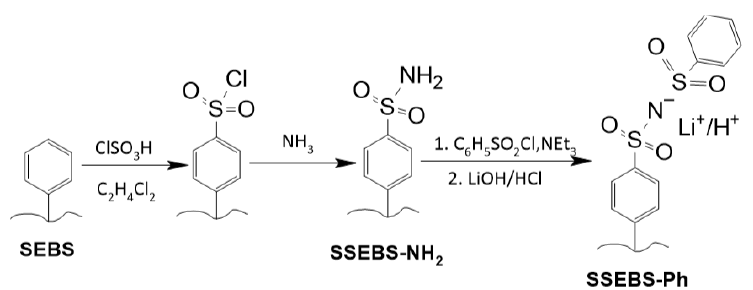
Figure 1. Scheme for obtaining the SSEBS-Ph